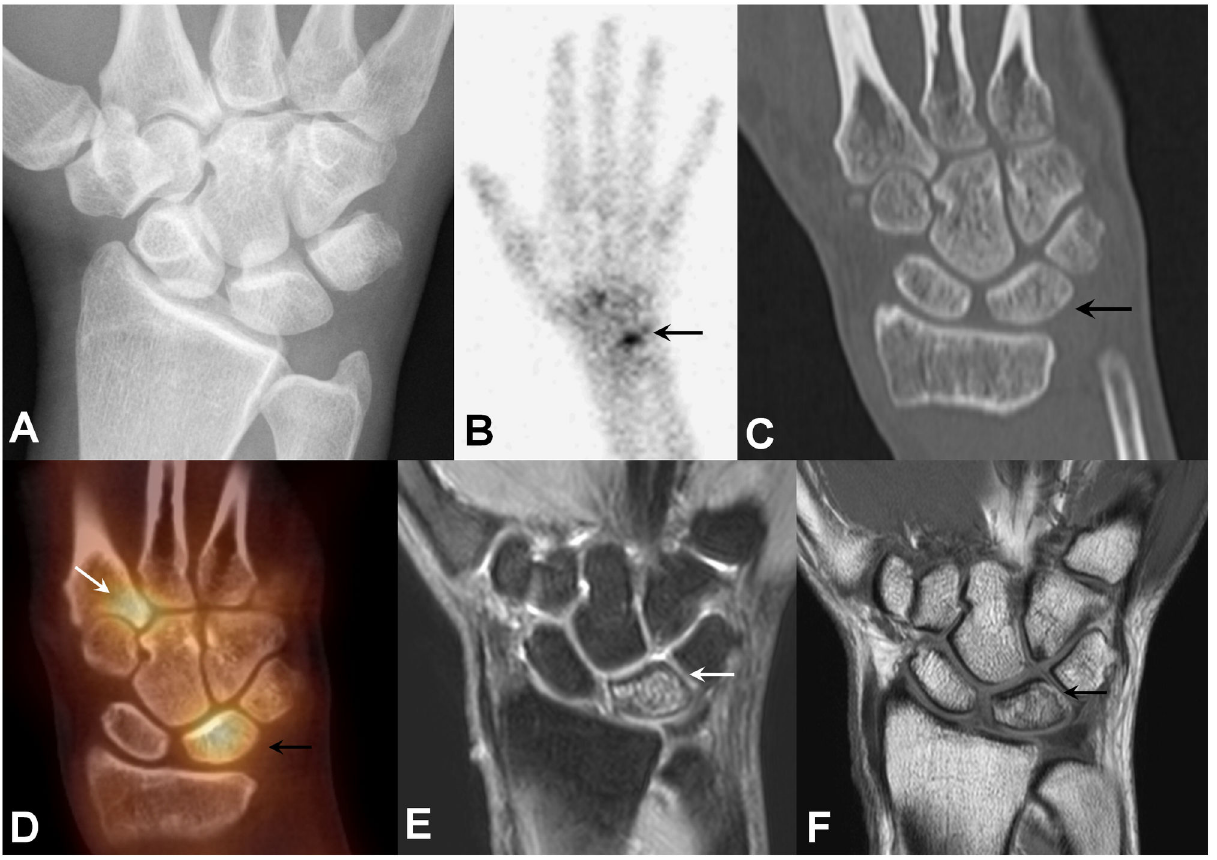
Figure 2. 44-year-old female with osteomalacia of the lunate bone. Relative shortness of the distal articular surface of the ulna on plain radiograph (a), focally increased radiotracer uptake in the carpal region on bone scan (b), slightly hyperdense and coarse trabecular structure of the lunate bone on CT (c), tracer accumulation throughout the lunate bone on SPECT/CT fusion image (d), altered signal of lunate bone marrow in PDw SPIR (e) and T1w image (f) on MRI. Besides, there is also focal tracer accumulation in the ulnar-sided base of the 2 nd metacarpal (d) indicating a “carpal boss”, which was not in the main clinical focus at that time. doi: